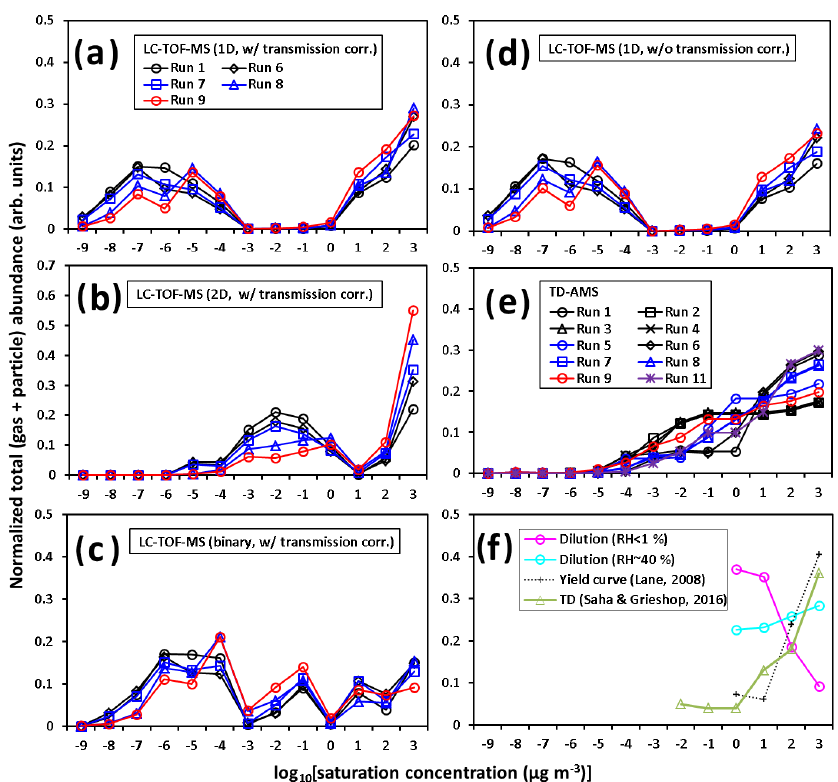
Figure 4. Volatility distributions determined for gas + particle products from (a) LC-TOF-MS data (1-D fit), (b) LC-TOF-MS data (2-D fit), (c) LC-TOF-MS data (binary fit), (d) LC-TOF-MS data (1-D fit, no transmission correction), (e) TD-AMS data, and (f) dilution data; The results of dilution data are compared with the volatility distribution determined from SOA yield curves (Lane et al., 2008) and TD measurements (Saha and Grieshop,